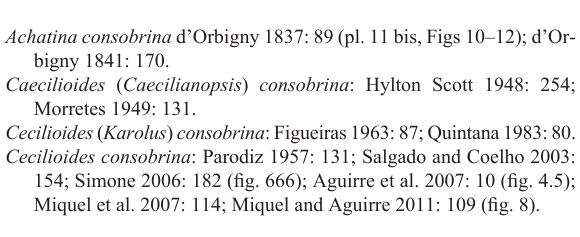
Synonymy see Hausdorf (2007). Complement: Pupisoma dioscoricola : Salgado and Coelho 2003: 153. Pupisoma discoricola [sic]: Simone 2006: 308 (fig. 9). Pupisoma ( Ptychopatula ) dioscoricola : Hausdorf 2007: 1483 (Figs 1–2, 6). Type locality. USA, Texas, Brownsville. Paralectotypes are from Mexico, San Luis Potosí, Valles Falls and Choy